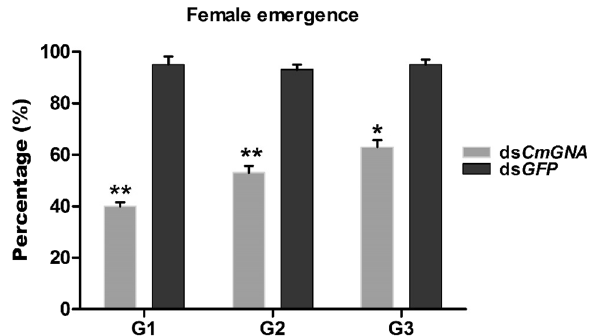
Figure 6. The percentage of emerged females after pupation. Each point indicates the mean ± standard error in G1–G3, and their control groups. Significant differences indicated by *(P < 0.05), **(P <